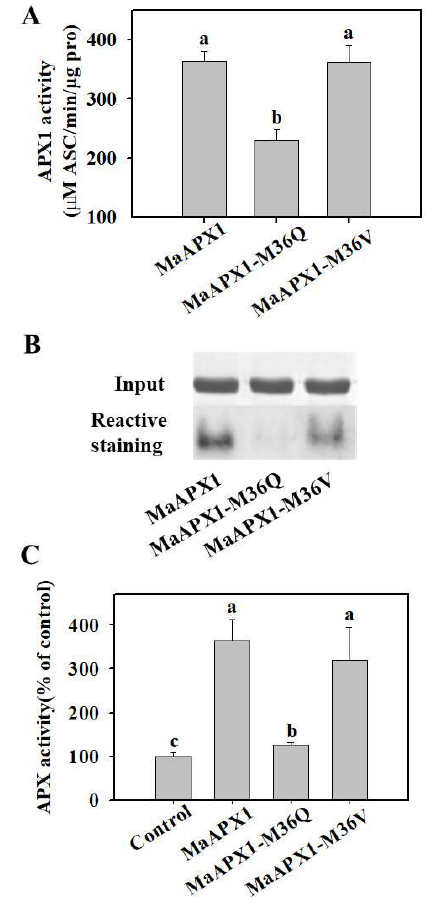
5 Figure 5. Mimicking sulfoxidation decreases MaAPX1 activity. MaAPX1-M36Q is a mutated form